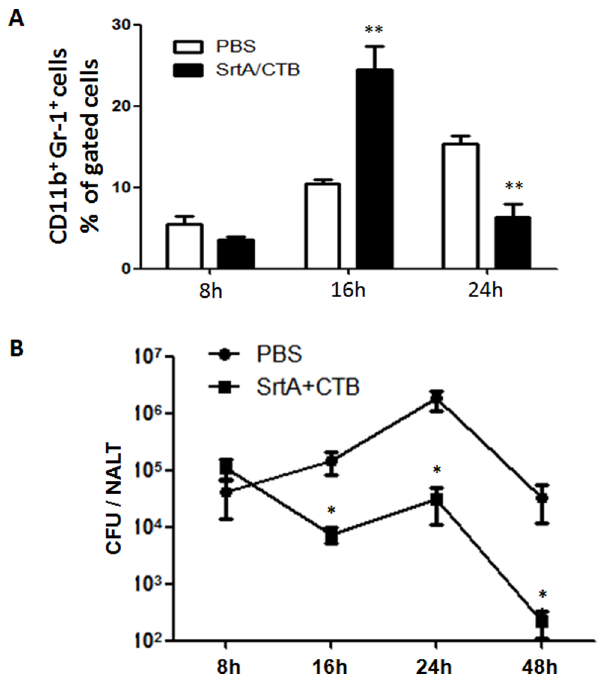
Figure 7. Neutrophil influx was rapidly increased in NALT of immunized mice in response to GAS challenge. Immunized C57B/ 6 mice were challenged with GAS M1 strain and sacrificed at the indicated time points after challenge. ( A ) Recruitment of neutrophils was determined by FACS analysis on NALT cells. Results are the mean 6 SEM of three mice per group. ( B ) CFUs in NALT were measured by plating NALT homogenates on blood agar plates. Data are the means 6 SEM of three mice per group. * P # 0.05, ** P # 0.01.